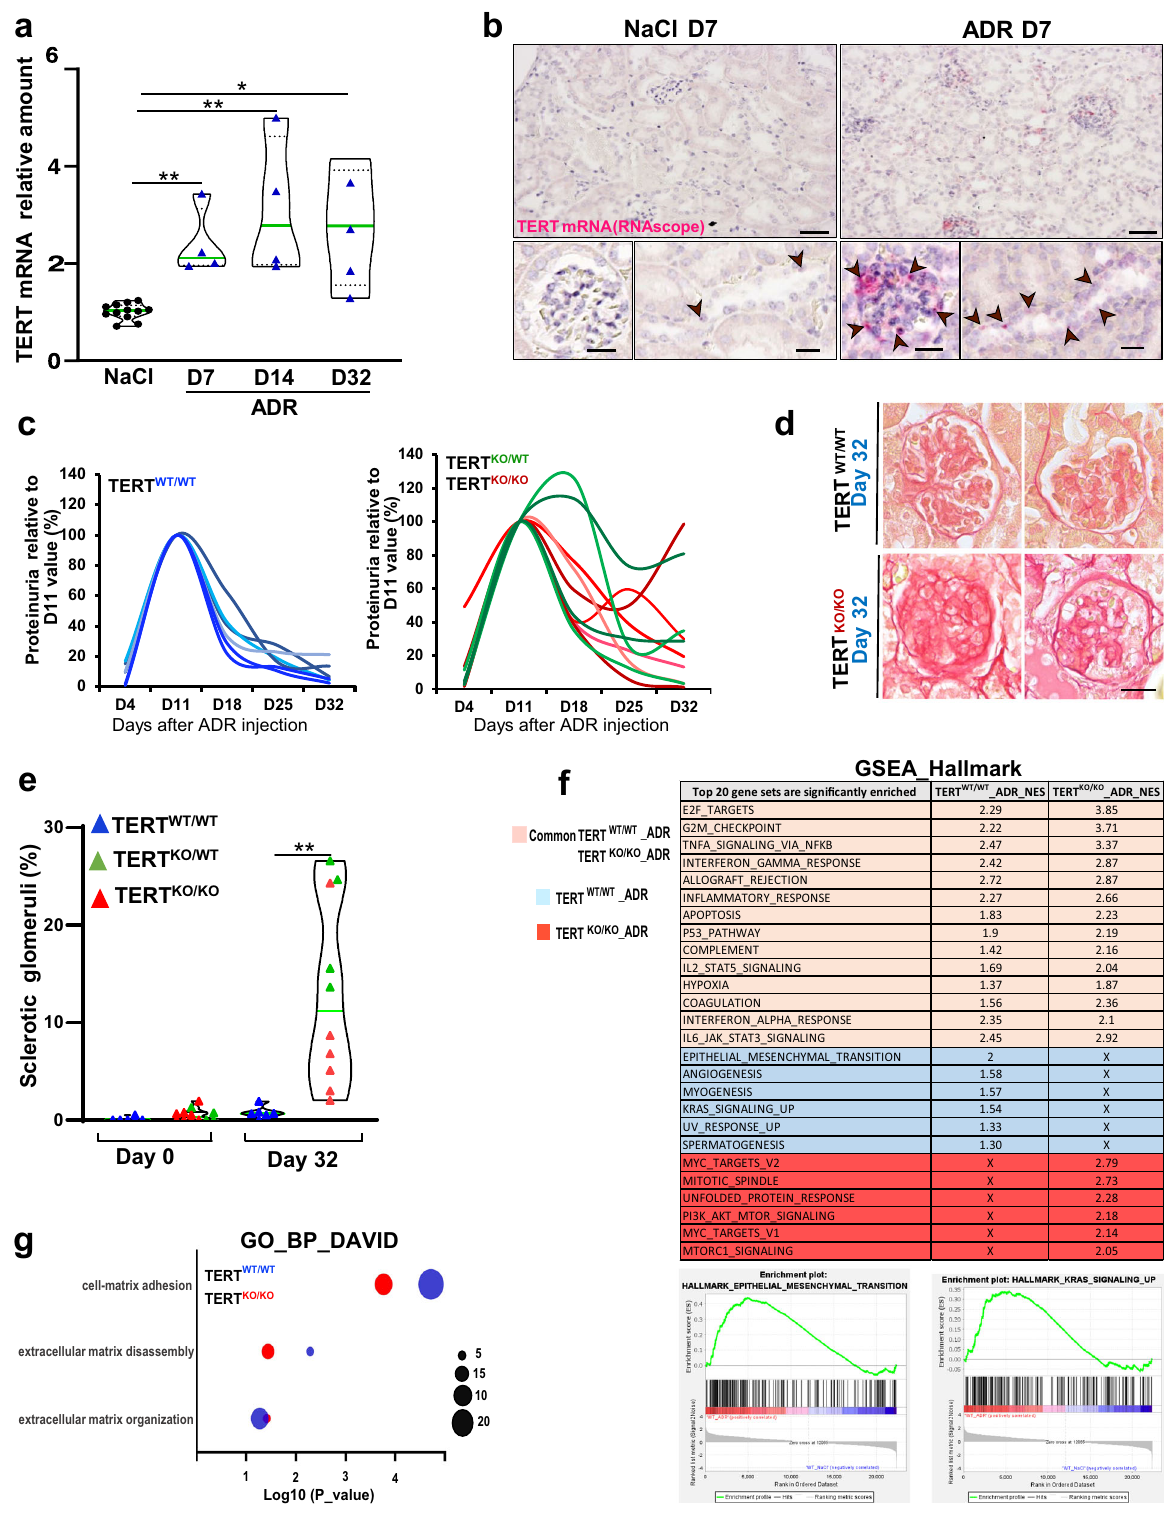
an increased prevalence of sclerotic glomeruli when compared to TERT WT/WT mice (Fig. 2e). Those results show that invalidation of endogenous TERT results in an increased number of sclerotic glomeruli following podocyte injury, suggesting a role